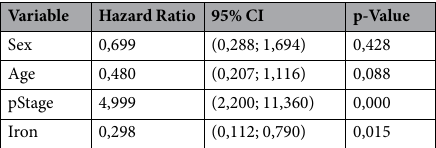
Table 2. Cox proportional hazards